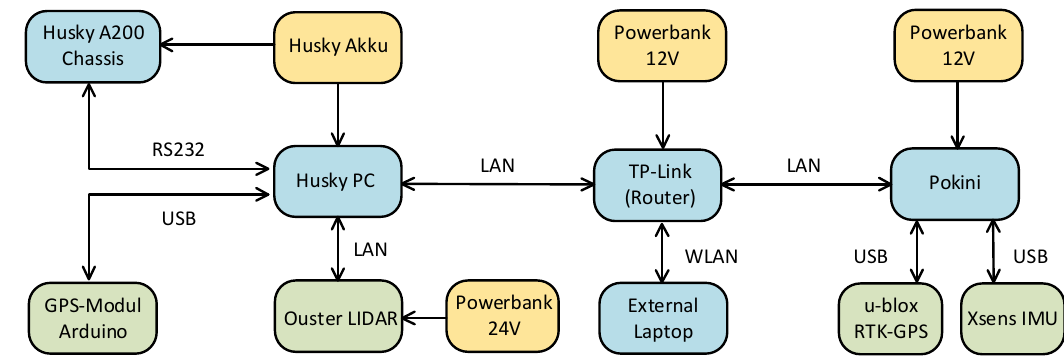
Figure 2. The hardware structure of the robot platform (based on [20]). ROS Structure Husky